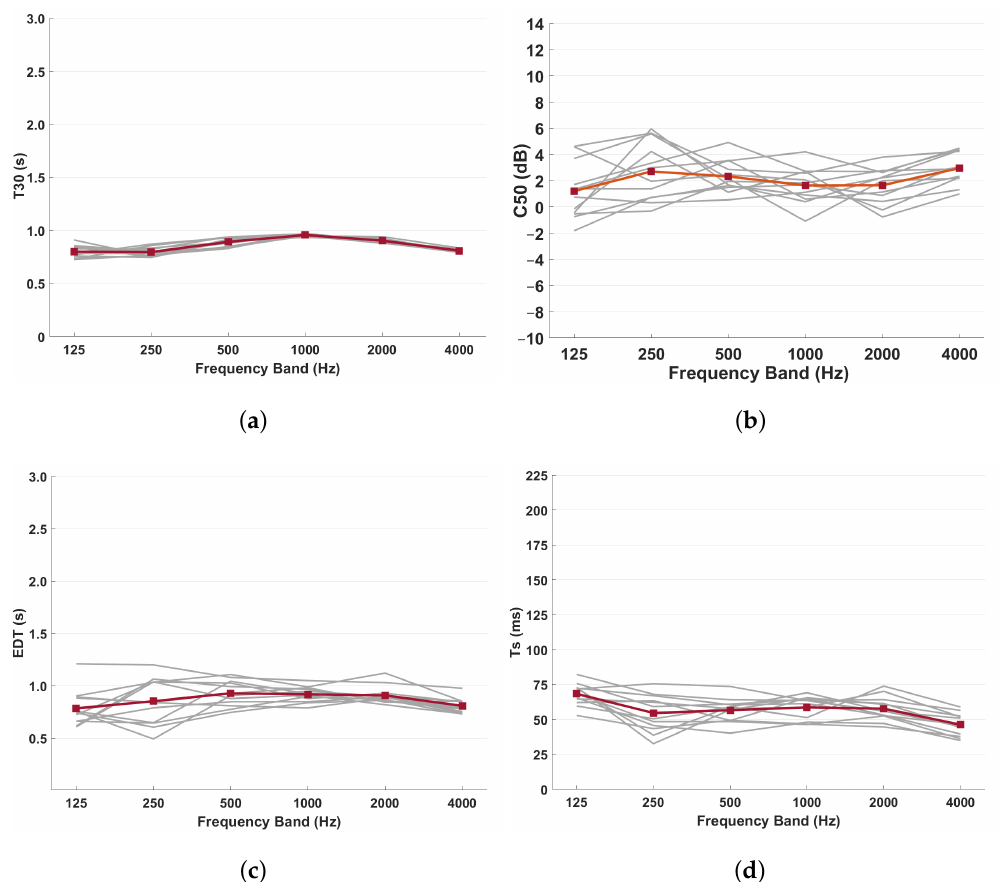
Figure 20. Results of the twelve individual measured positions in York Guildhall Council Chamber and the average values across frequency bands for ( a ) T30, ( b ) C50, ( c ) EDT and ( d )